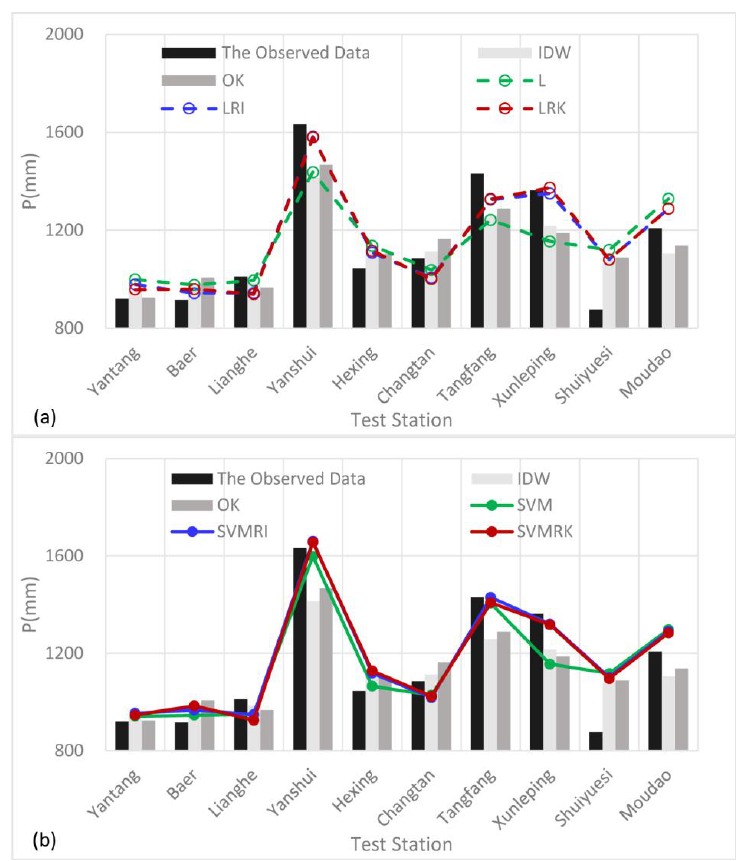
Figure 7. Test station multi-year average annual precipitation (( a ) linear regression and its hybrid interpolation method; ( b ) support vector machine and its hybrid interpolation method).